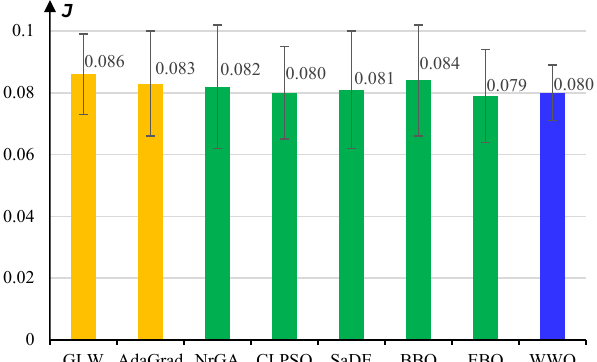
Figure 5. Average reconstruction errors and standard deviations of the comparative algorithms for pretraining the upper individual-specific layers of the Behavior Learner .